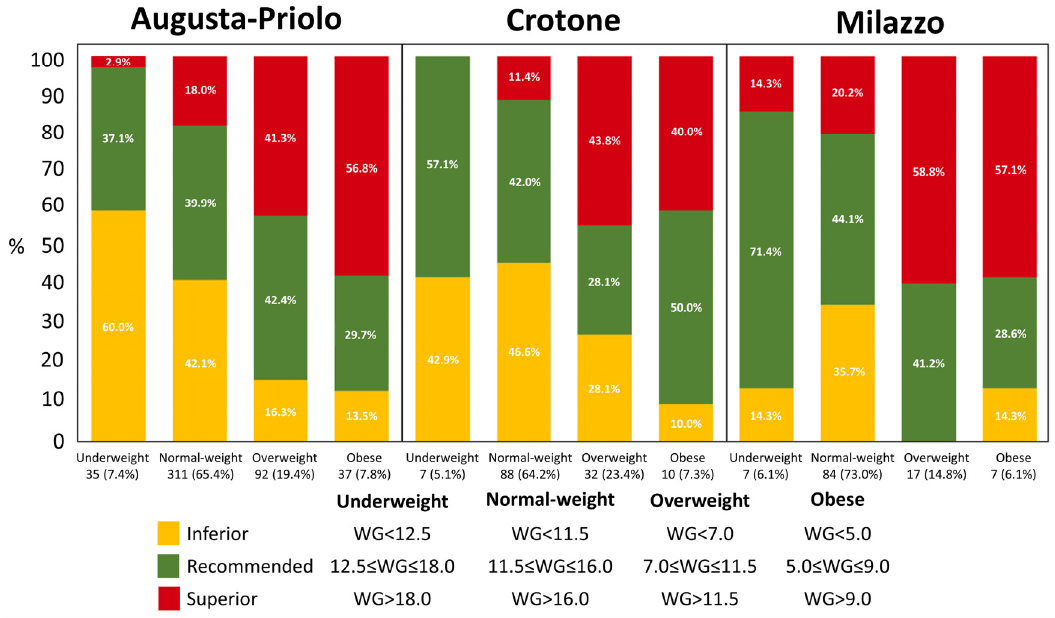
Figure 1. Distribution of weight gain in the categories “superior”, “recommended”, and “inferior” with respect to body mass index (BMI) baseline values within each national priority contaminated site.